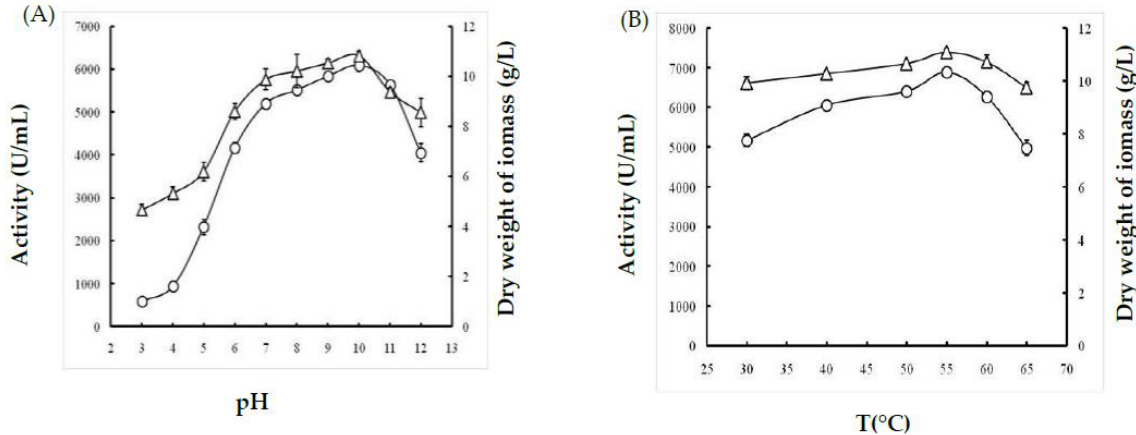
Figure 1. Effects of ( A ) temperature and ( B ) pH on growth (triangles) and protease production (bars) from Bacillus stearothermophilus . Data are expressed as mean ( n = 3) ± SD.